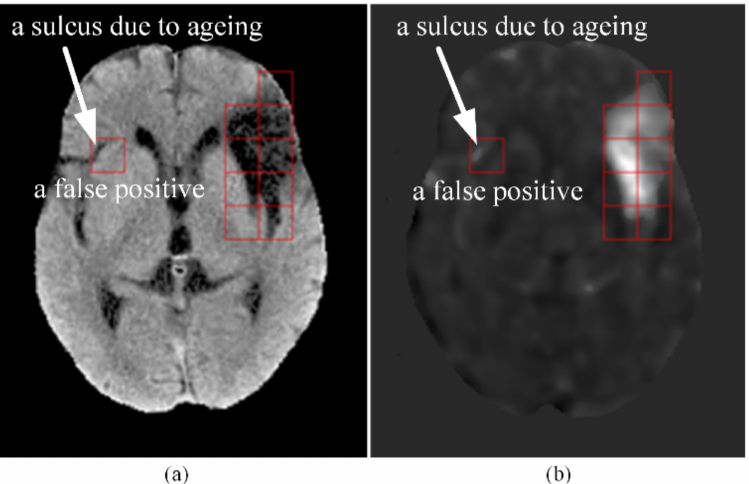
Figure 7. An example of a false positive caused by age mismatch between the control group and the patient group. ( a ) An elderly patient’s CT slice after Step P5. The dark area inside the red square on the right hemisphere was non-infarcted and was a sulcus due to ageing. ( b ) The t-score map of the CT slice after Step P7. Notice the high t-scores in the sulcus encompassed by the red square on the right hemisphere, which led to a false positive detection of this